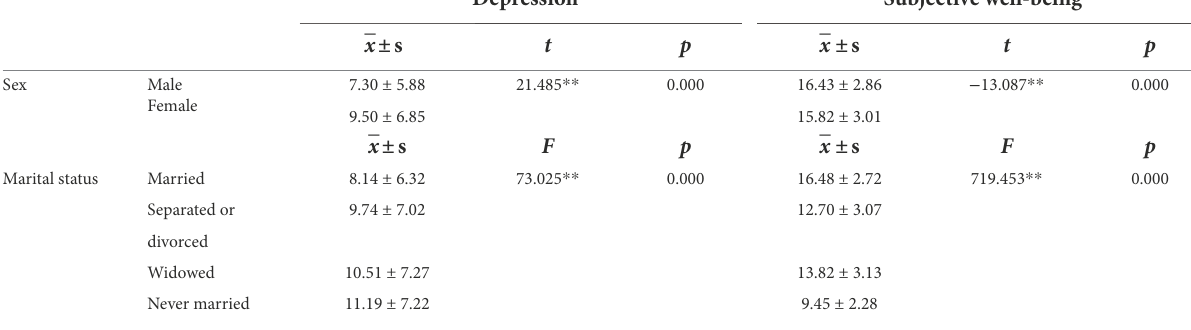
TABLE 2 A differential analysis of sex, marital status, subjective well-being and depression ( n =